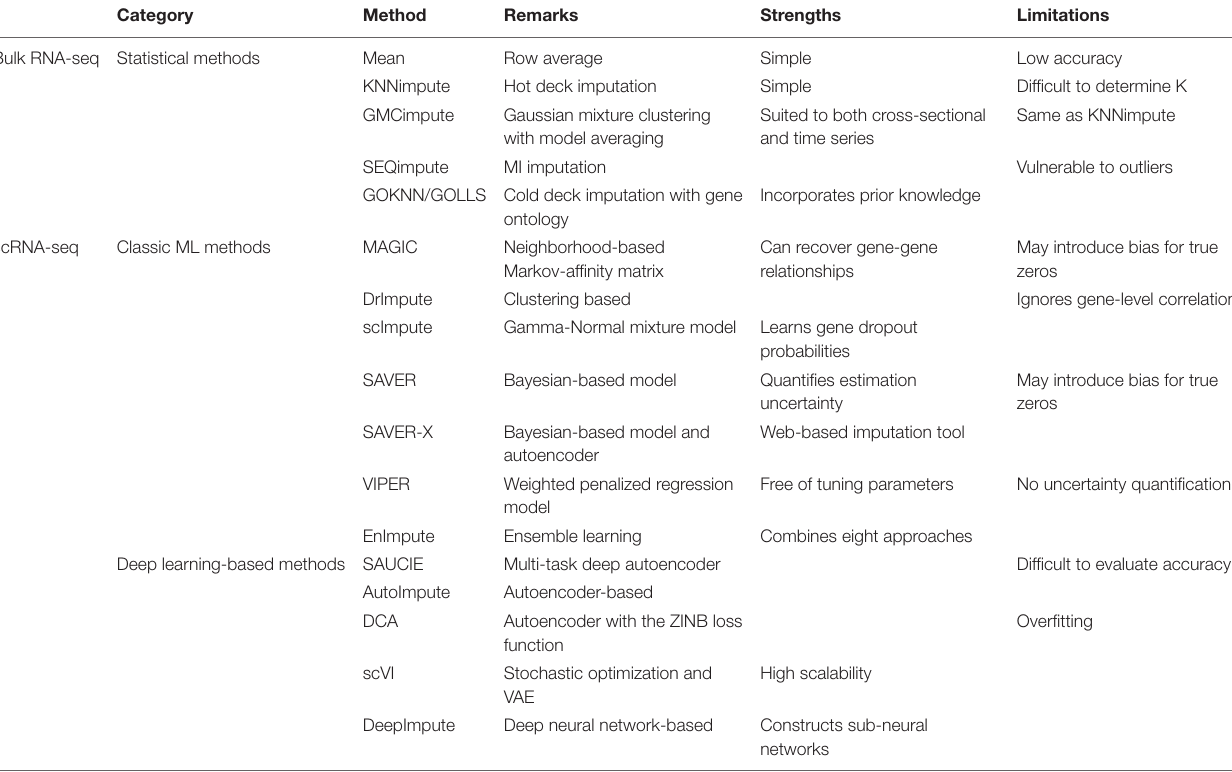
TABLE 2 | Gene expression data imputation methods.